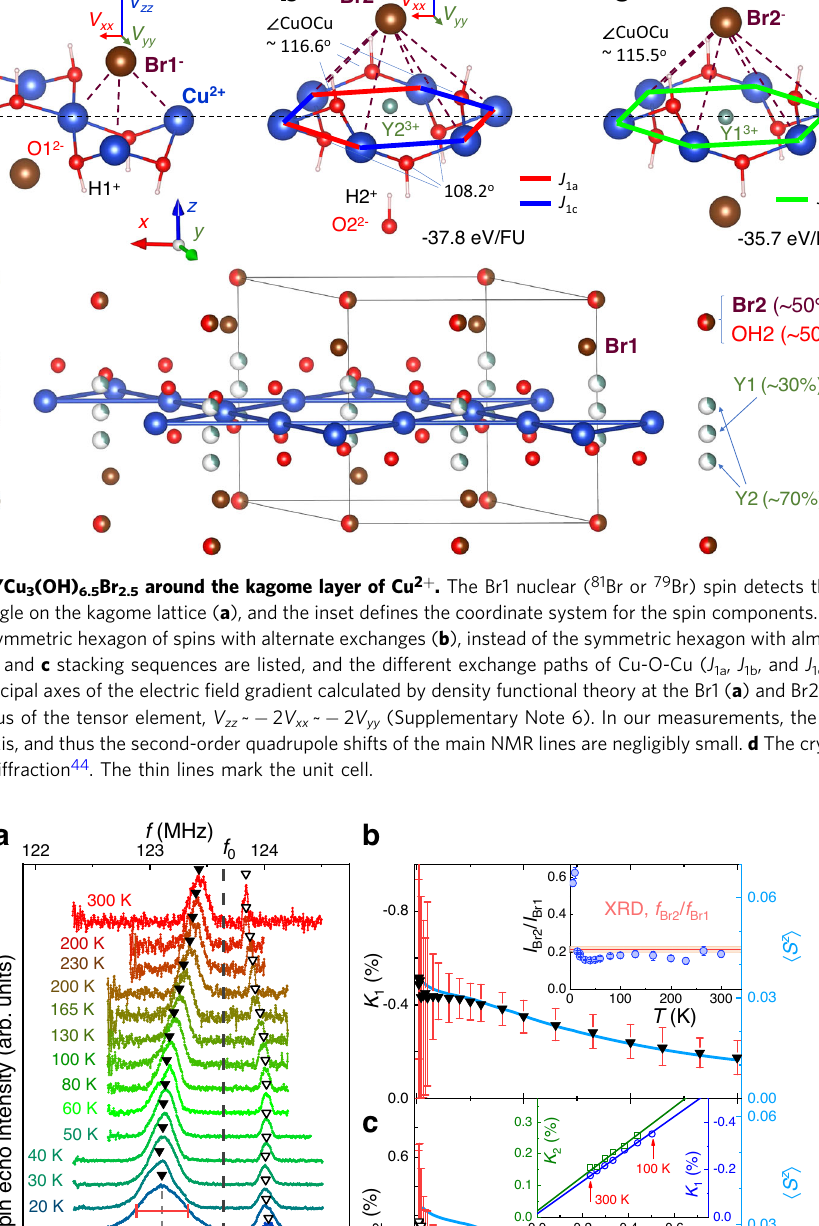
COMMUNICATIONS PHYSICS| (2022) 5:272